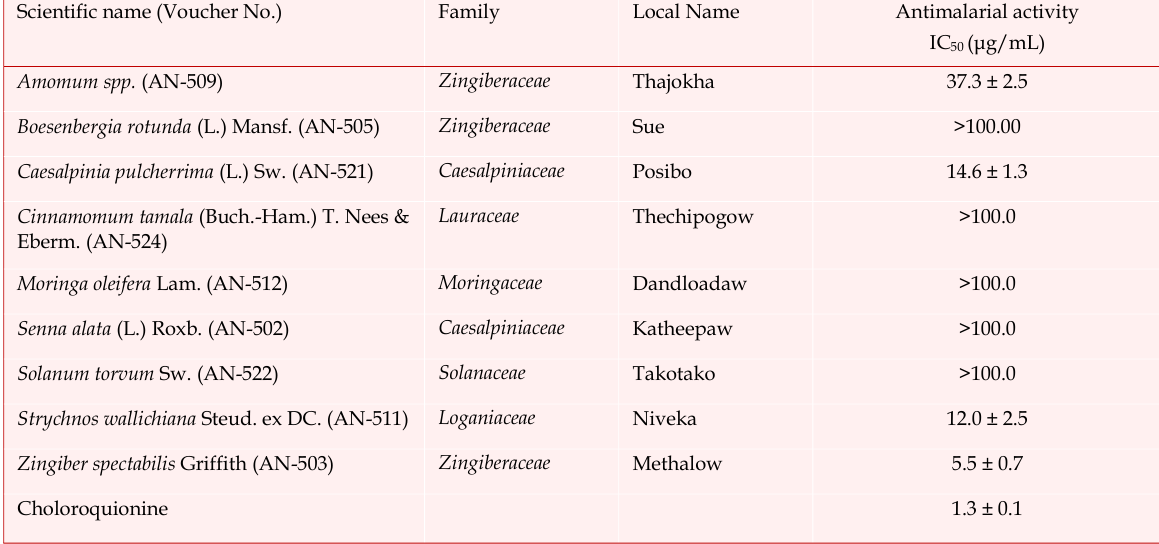
Antimalarial activity of ethnomedicinal plant used by Karens of Andaman and Nicobar